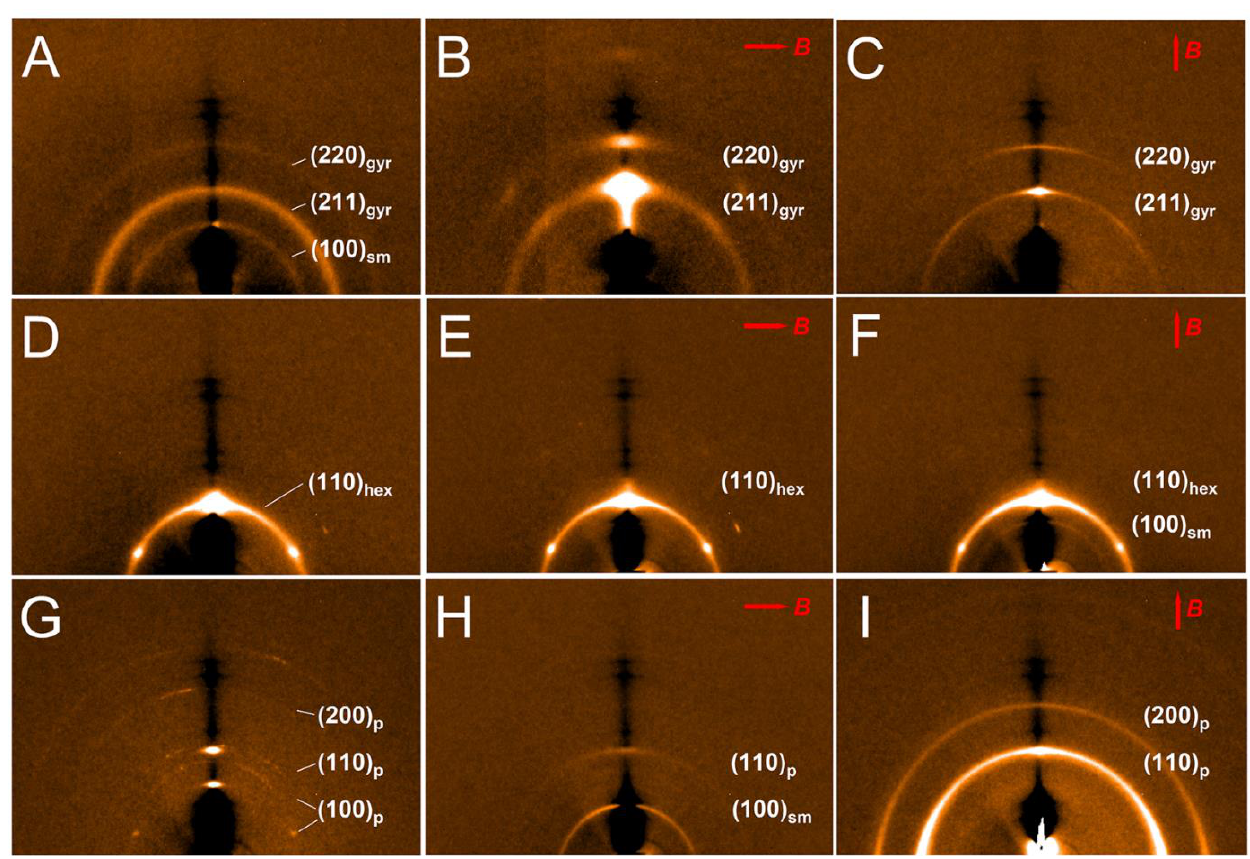
Figure 6. 2D GIXD patterns of TDOBSH ( A – C ), TDOBSNa ( D – F ) and TDOBSPyr ( G – I ): left column – before application of MF, middle column — with MF parallel to the film, right column — with MF normal to the film. The most intense reflections are marked with white arrows and indexed according to smectic (sm), gyroid (gyr), columnar hexagonal (hex) and cubic primitive (p) phases. The film was oriented horizontally. Red arrow indicates direction of magnetic field with respect to the film surface. The black regions appear after background substruction.